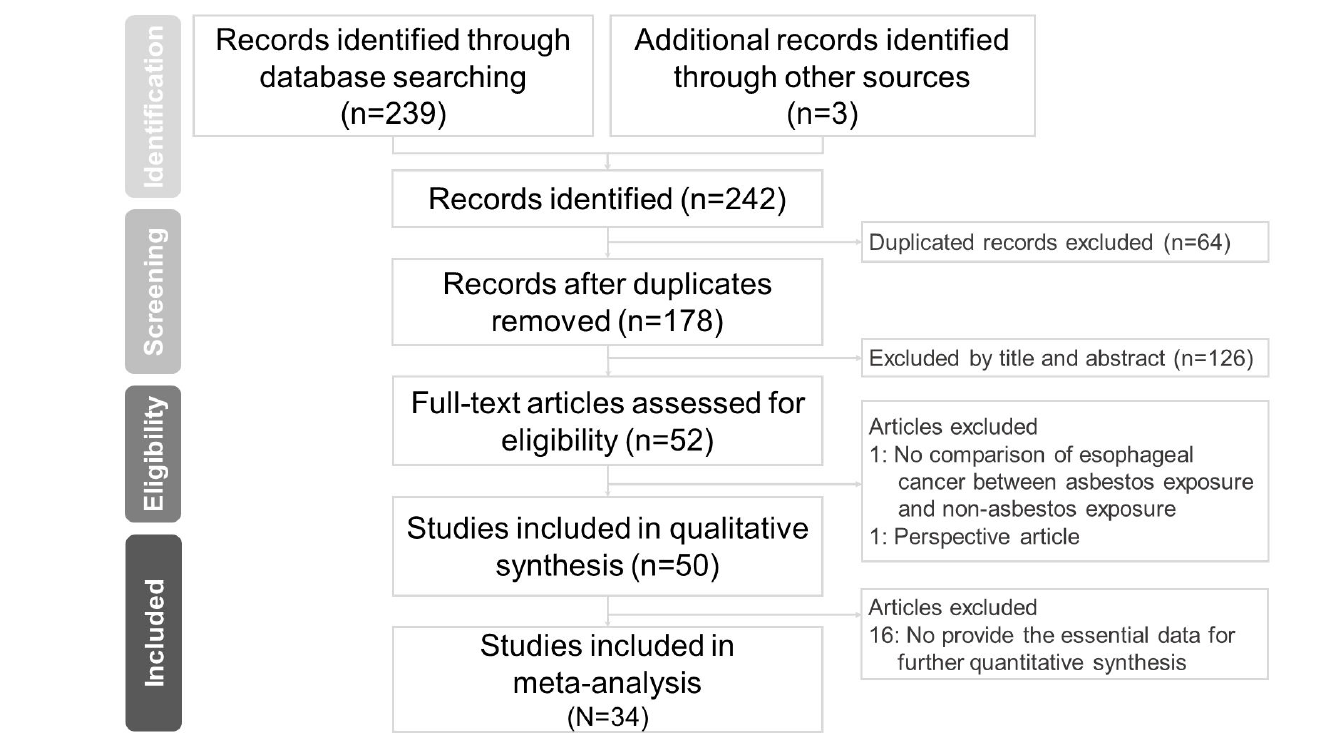
Figure 1. Preferred Reporting Items for Systematic Reviews and Meta-Analyses flow